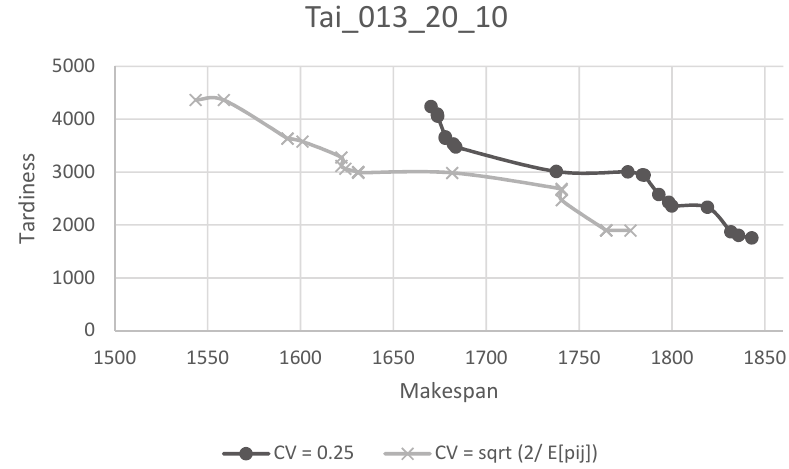
Fig. 5. Pareto fronts of Taillard’s instance 13 (20 jobs × 10 machines)